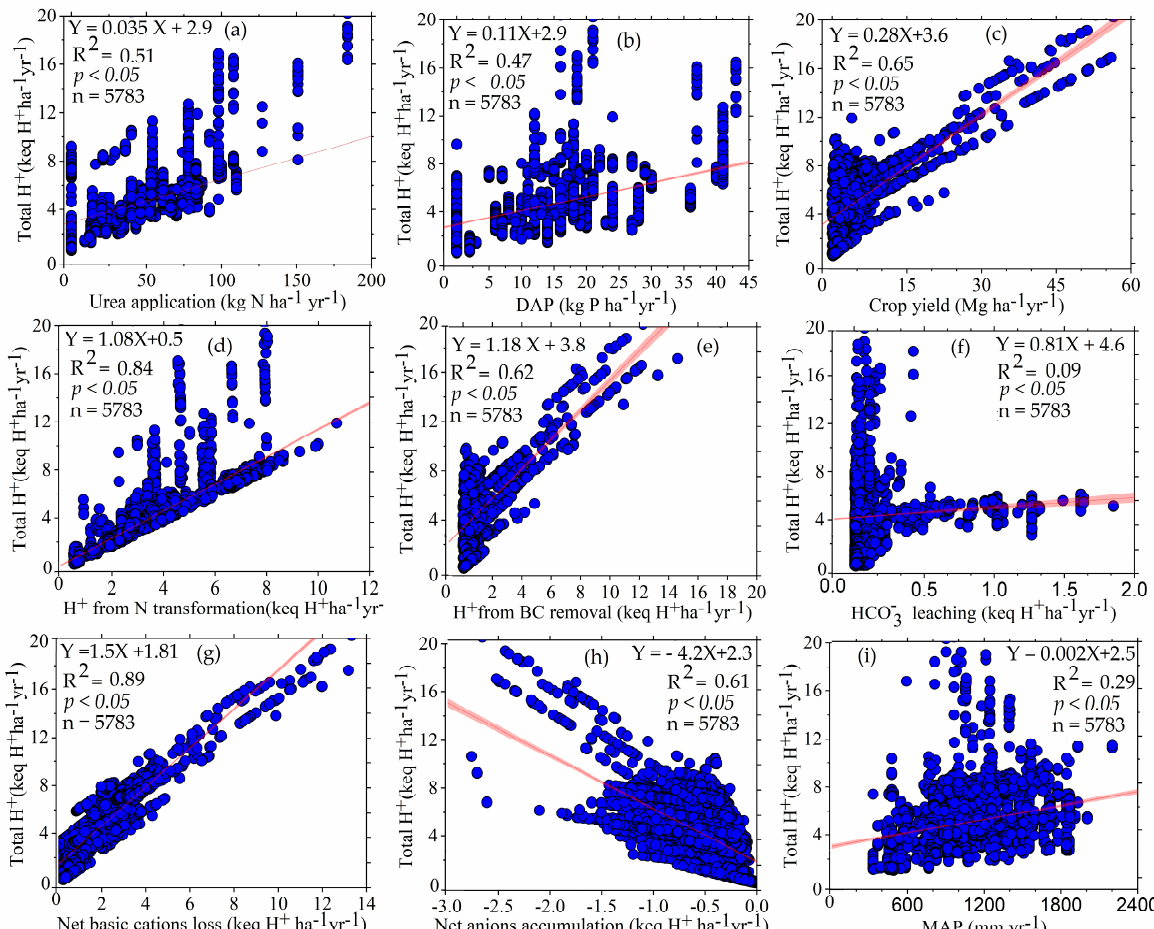
Figure 7. Relationships of soil acidification (H + ) and its drivers: relationship of total H + with urea application rate ( a ), with diammonium phosphate application rate ( b ), with crop yield ( c ),with N transformation (N deposition, N hydrolysis, nitrification, and N leaching) ( d ), with basic cation removal (basic cation minus anion crop uptake) ( e ), with bicarbonate leaching ( f ), with net basic cation loss ( g ), with net anion accumulation ( h ), with mean annual precipitation (MAP) ( i ). The pink area refers to the 95% confidence interval around the regression line and n is the number of observations.